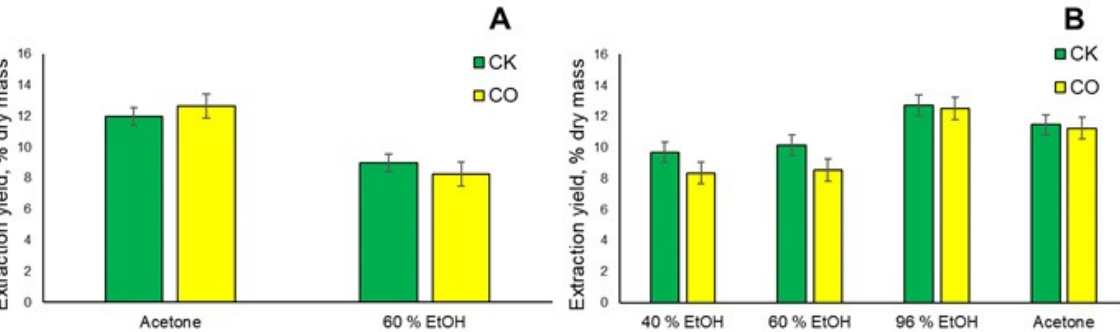
Figure 4. ( A ) Total extraction yield % of spent coffee ground sequential extraction with organic solvents, replacing n-hexane with acetone as the first extraction solvent. ( B ) Total extraction yield % of spent coffee grounds single step extraction with ethanol aqueous solutions in different concentrations and acetone as extraction solvent ( n = 3, error bars indicate SD).